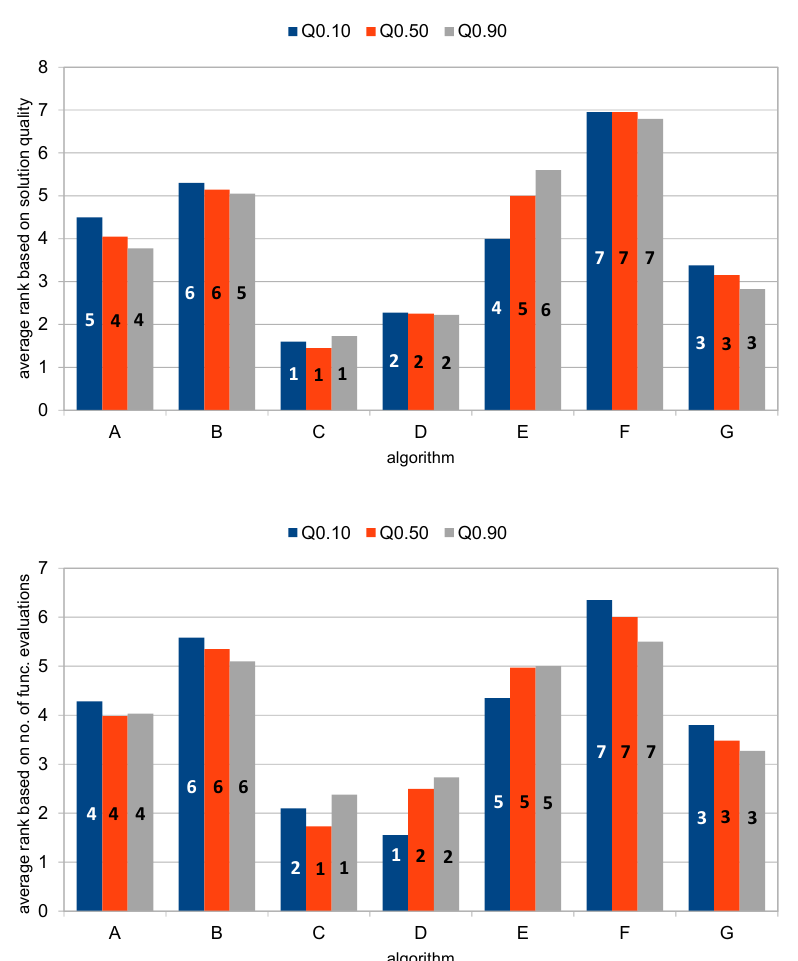
Figure 3. Average ranks based on Q 0.10 , Q 0.50 and Q 0.90 in the case of the observed solution quality and the number of function